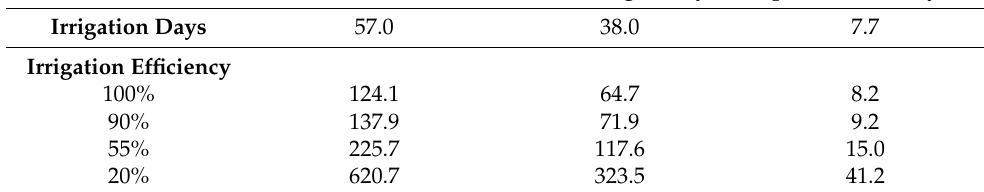
Figure 6. Multi-year daily averages of soil water storage for the potato GS under no irrigation (i.e., Meas. no irrig.) and three supplemental irrigation scenarios.